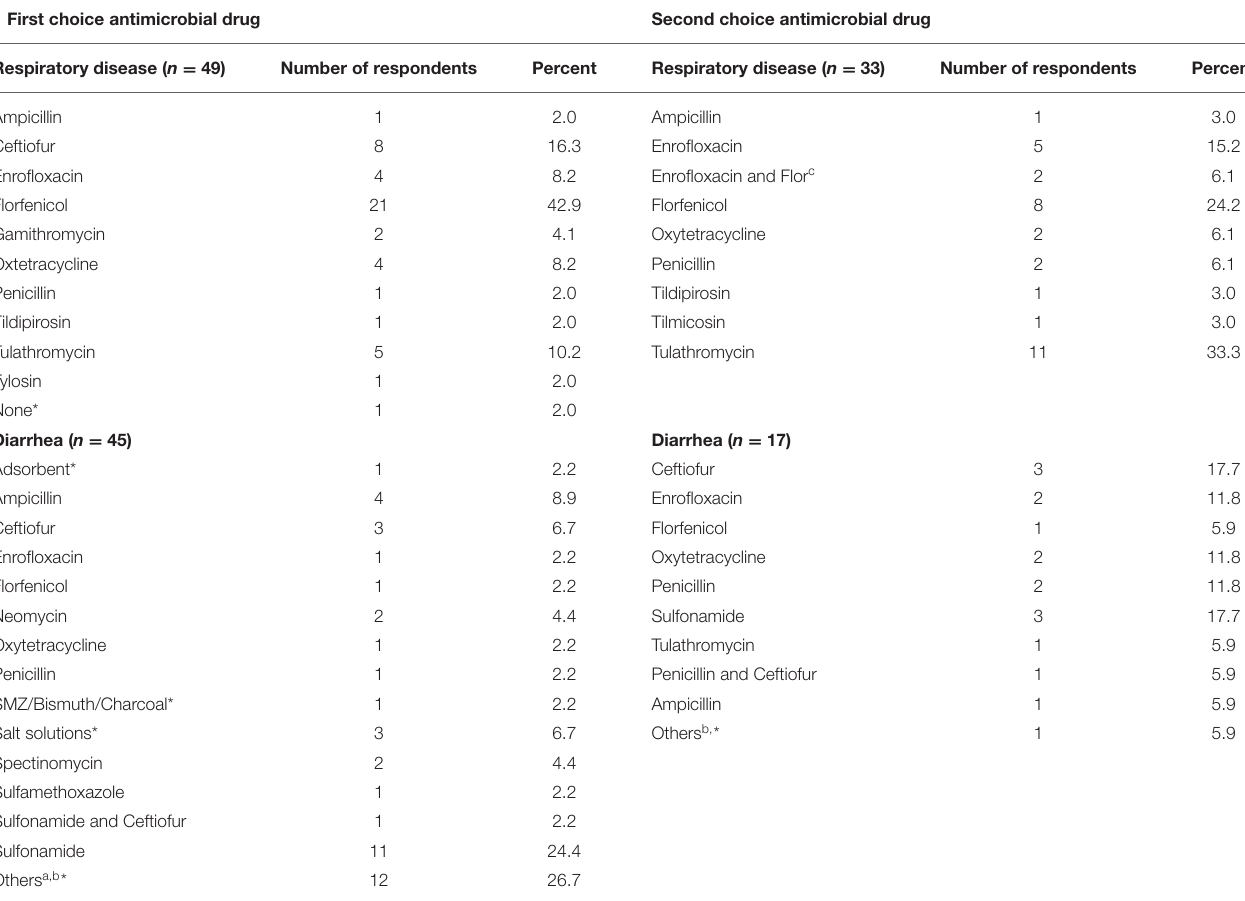
TABLE 7 | Antimicrobial drugs used to treat respiratory disease and diarrhea in preweaned calves after January 1, 2017 on California dairies. First choice antimicrobial drug Second choice antimicrobial